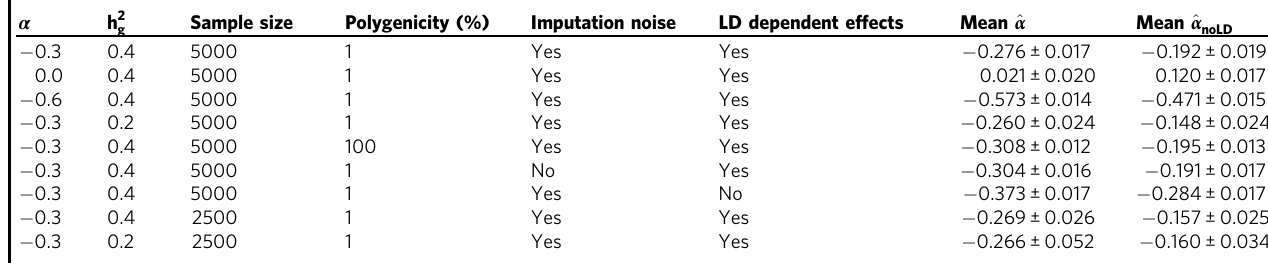
Table 1 Estimates of α in